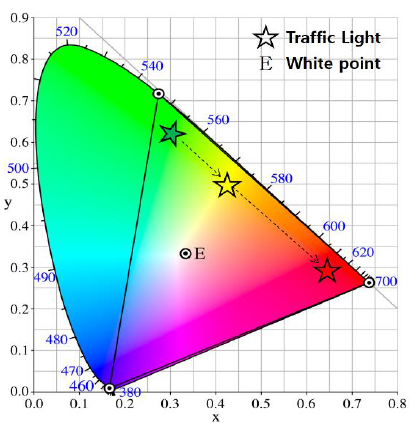
Figure 7. An example of target color transition in a color-space-based constellation diagram.